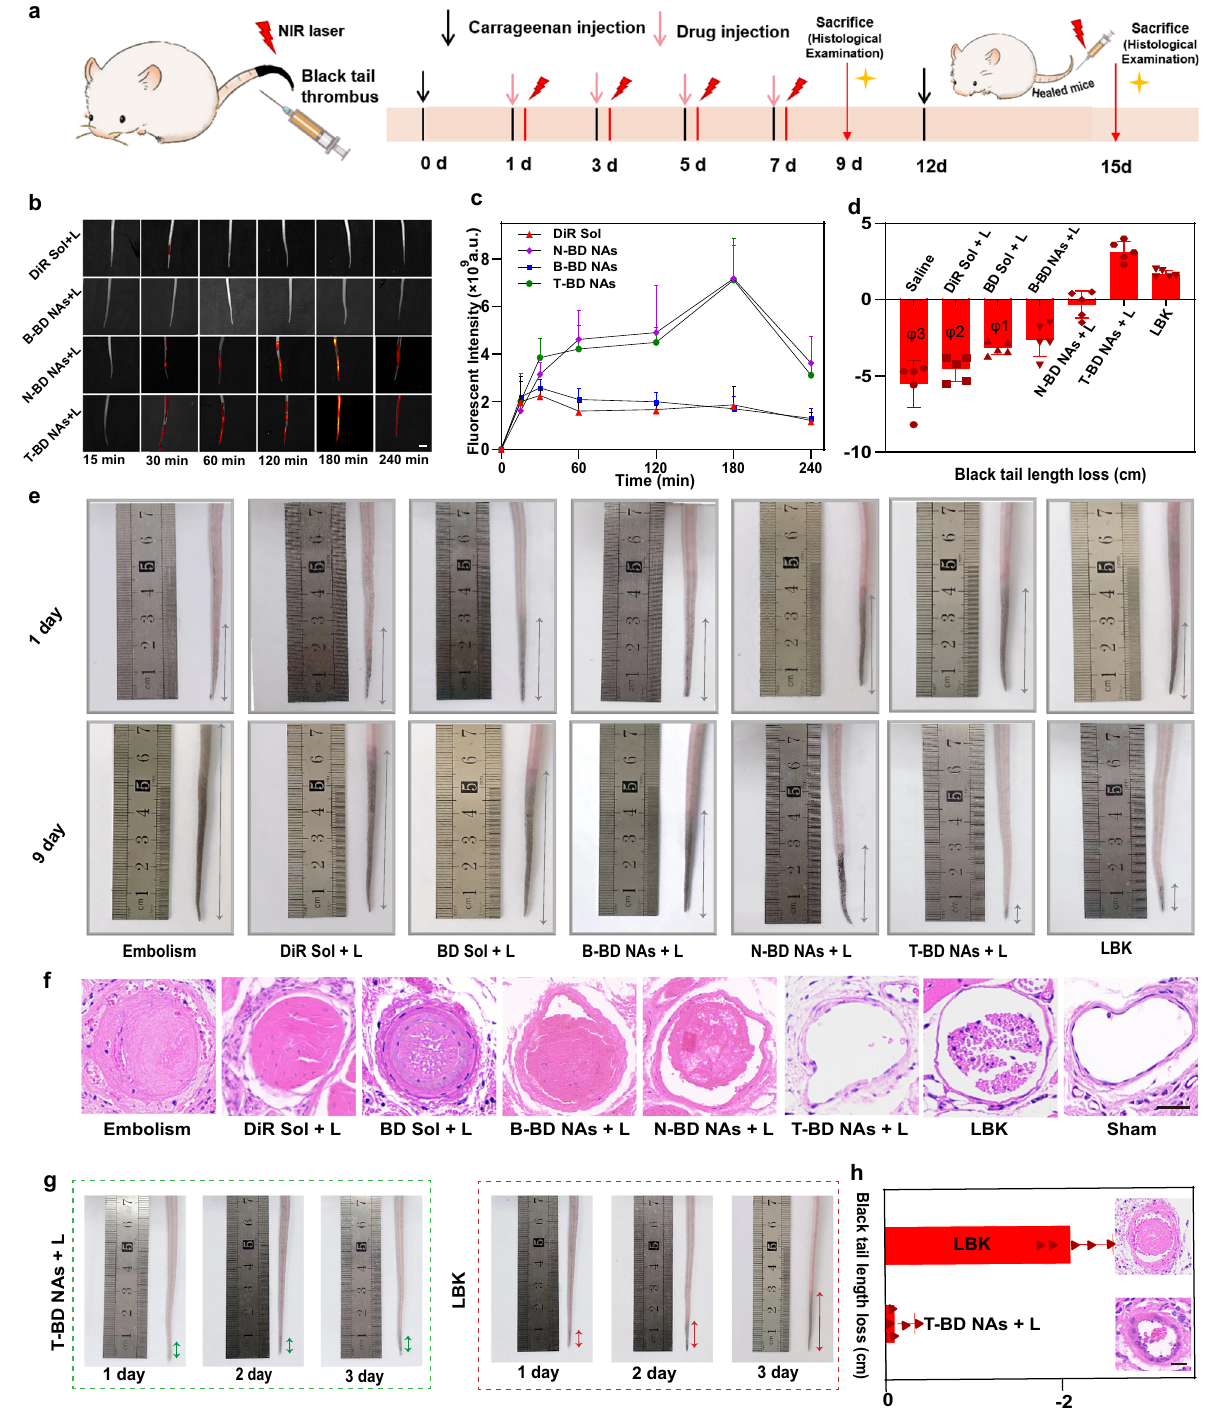
Fig. 6 | Intravenous thrombolysis and prevention recurrence of thrombus ( n =5).a Treatmentschemeinintravenousthrombolysistherapy. b Representative fl uorescence images (scale bar=1cm) and c quantitative results of the tail throm- bus model mice after different treatments (DiR equivalent dose 5mg/kg). Data are presented as mean±SD. Source data are provided as a Source Data fi le. d The average black tail length loss of the tail thrombus model mice before and after 9 days with the injection ofdifferent formulations with or without laser irradiation (DiRequivalentdose5mg/kg, φ representstheamputatedtail).Dataarepresented asmean±SD.SourcedataareprovidedasaSourceData fi le. e Photosofblacktails